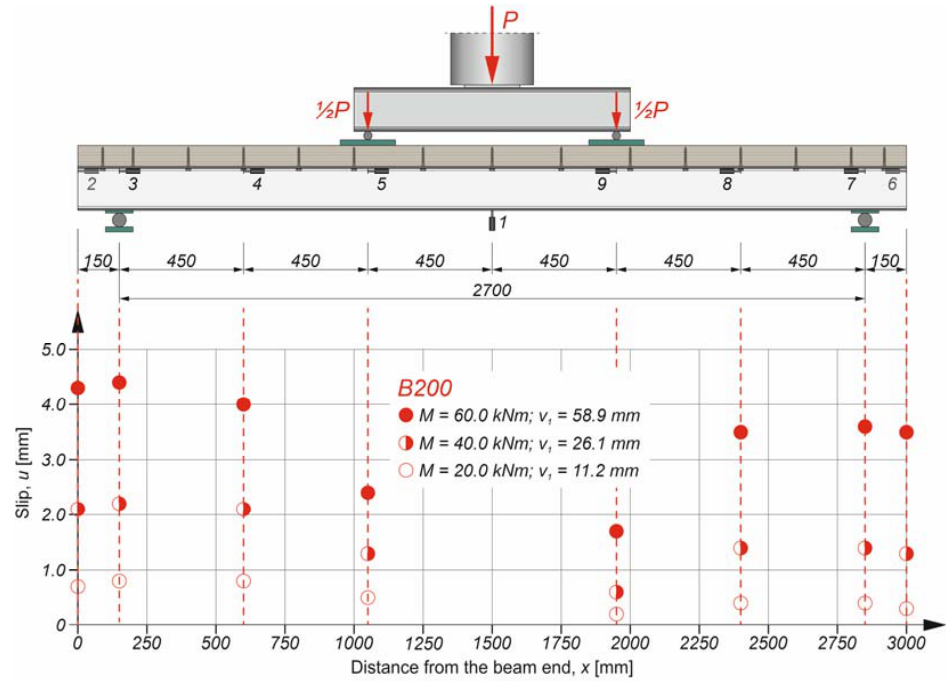
Figure 10. Slip distribution in the B200 composite beam.